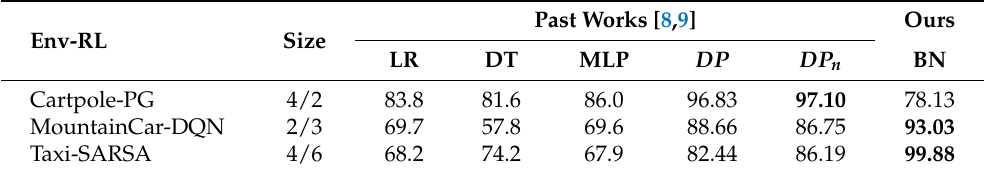
Table 8. Comparison of the accuracy (%) in prediction obtained with different methods: LR is the Linear Regression, DT is the Decision Tree, MLP is the Multi-Layer Perceptron, DP is the Decision Policy Tree, DP n is the Decision Policy Tree with a fixed depth and BN is the Bayesian Network. Past Works Env-RL Size